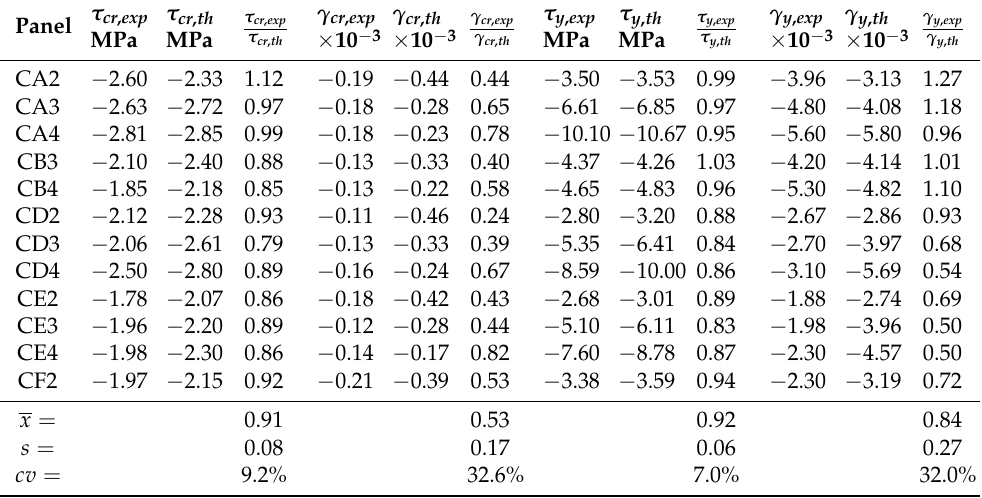
Table 4. Comparative analysis: negative ( − ) loading shear direction (cracking and yielding